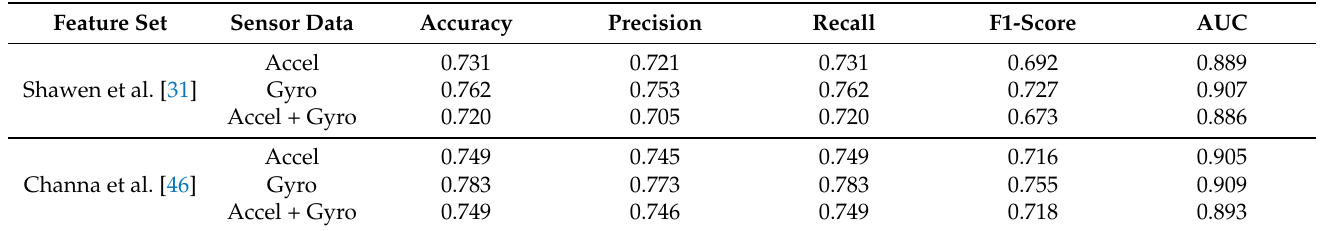
Table 2. Baseline methods. Accel: Accelerometer; Gyro: Gyroscope.